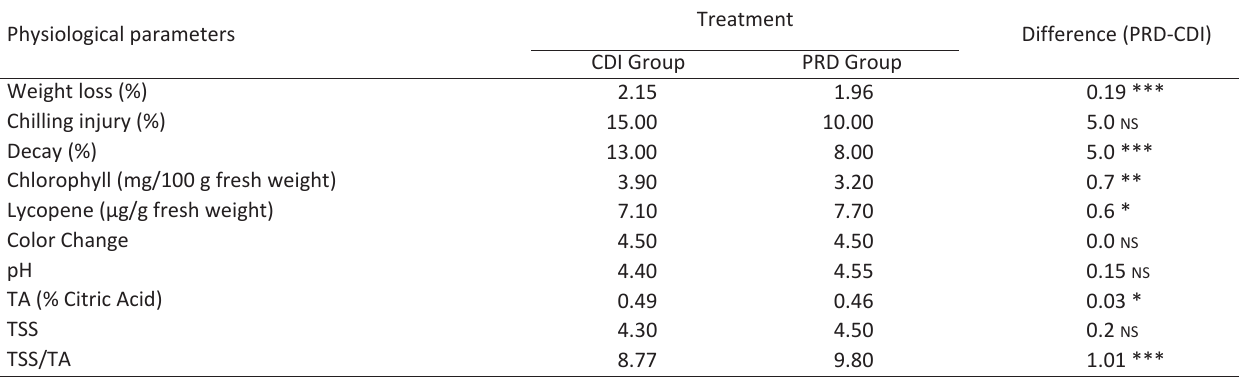
Table 2 - Effect of PRD on weight loss, chilling injury, decay, chlorophyll content, lycopene content, color change, pH, titratable acidity (TA), total soluble solid (TSS), and TSS/TA in mature green tomatoes on the 7th day at 24°C following a 2-week storage period at 3°C Physiological